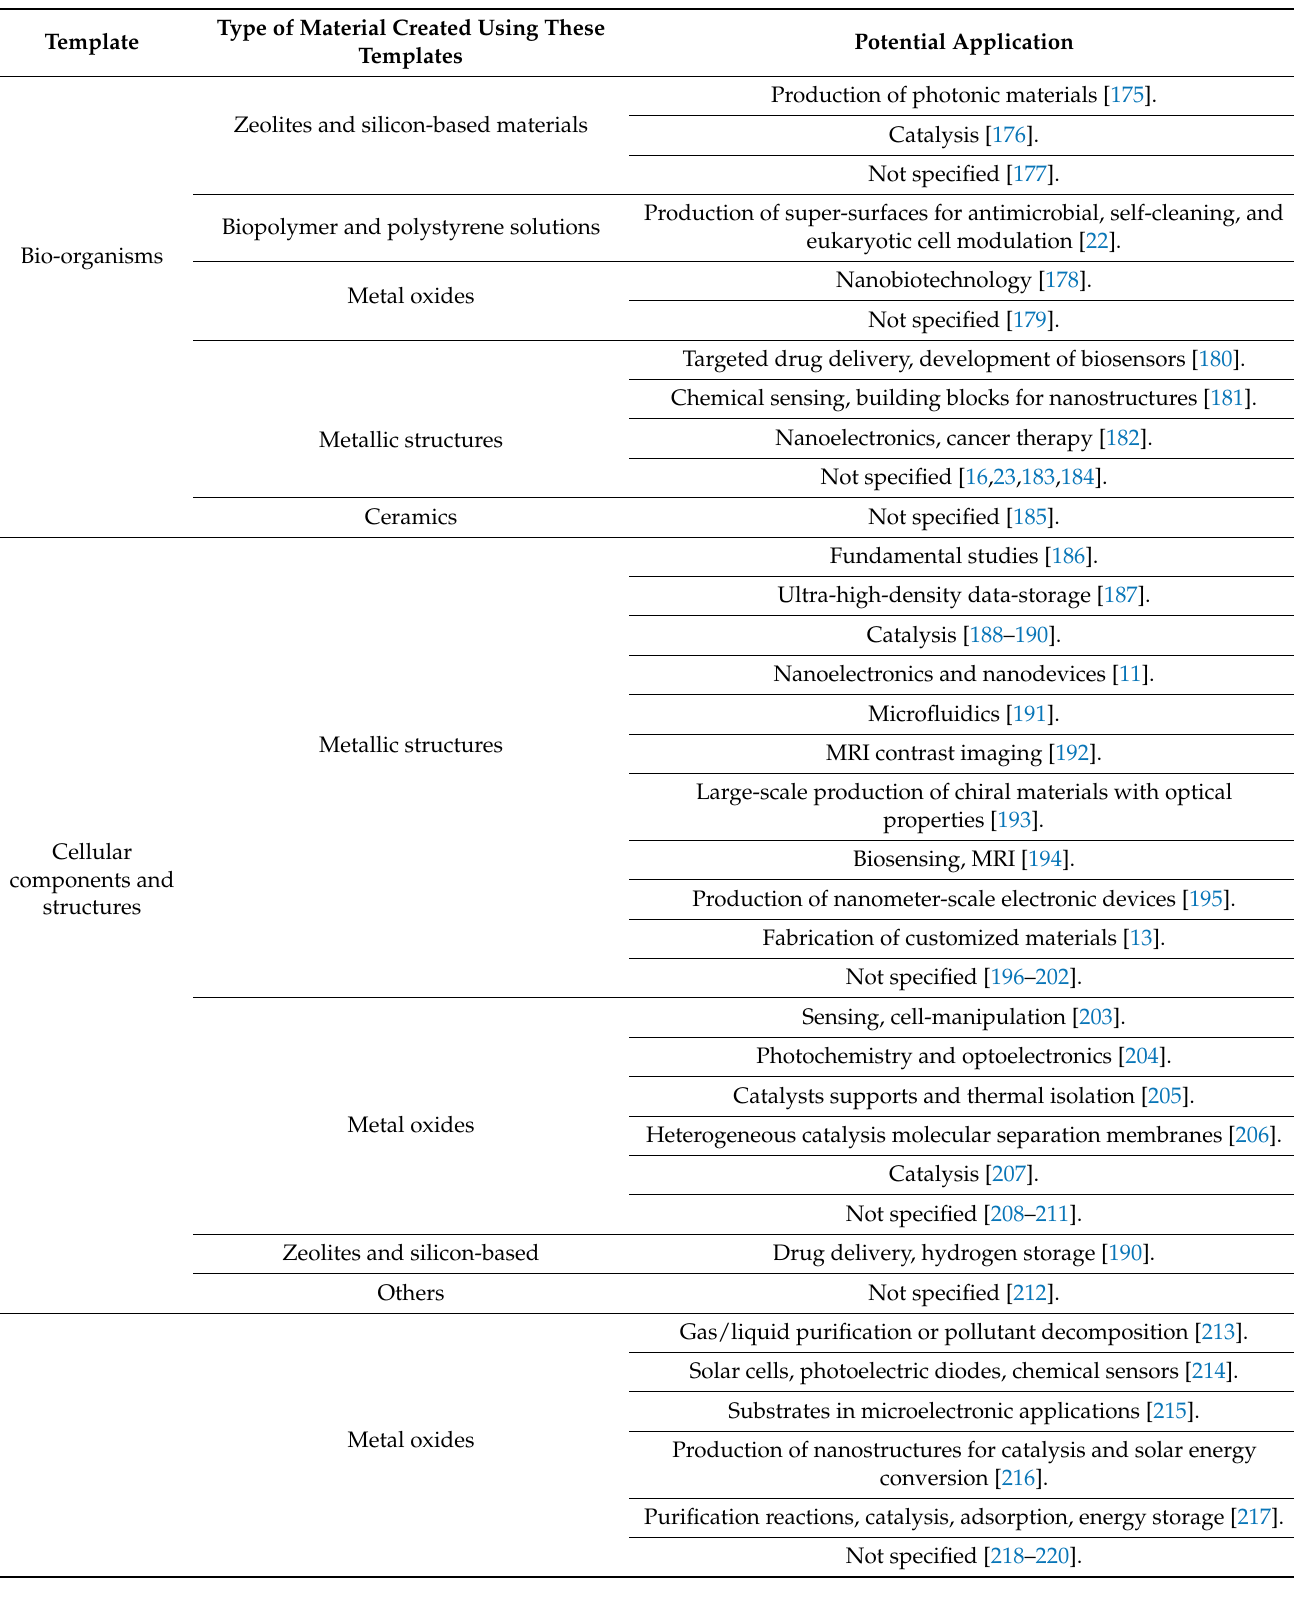
Table 1. Potential application of some materials created through biotemplating distributed by template and the type of material that was